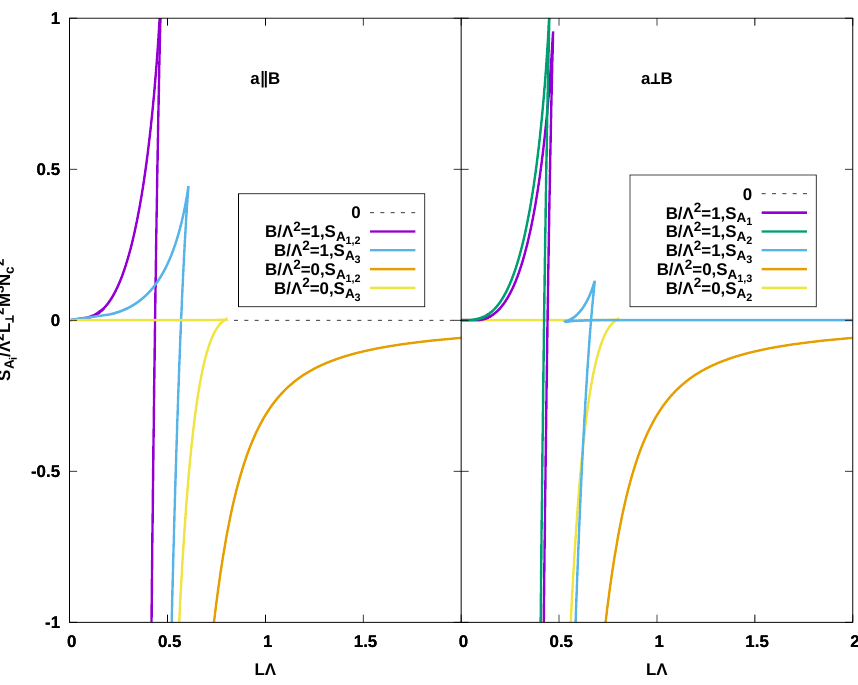
Figure 8 . Entanglement entropy in the presence of both anisotropy and magnetic field, for a = 1 and B = 1 (in units of Λ ∼ 1 GeV), and c = 0 . 25 . The magnetic field B is aligned along the z -direction while the anisotropic deformation is introduced along the z - or y -direction (parallel and perpendicular configurations, respectively). For the parallel case, we still find the disentangling transition regardless the orientation of the strip, which is inherited from the purely magnetic case. entanglement entropy is never dominated by the disconnected solution. This behavior is inherited from the purely anisotropic case [26], specifically, for the case of strips orthogonal to the